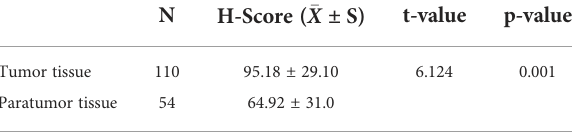
TABLE 1 SIGLEC15 expression levels in different pathological